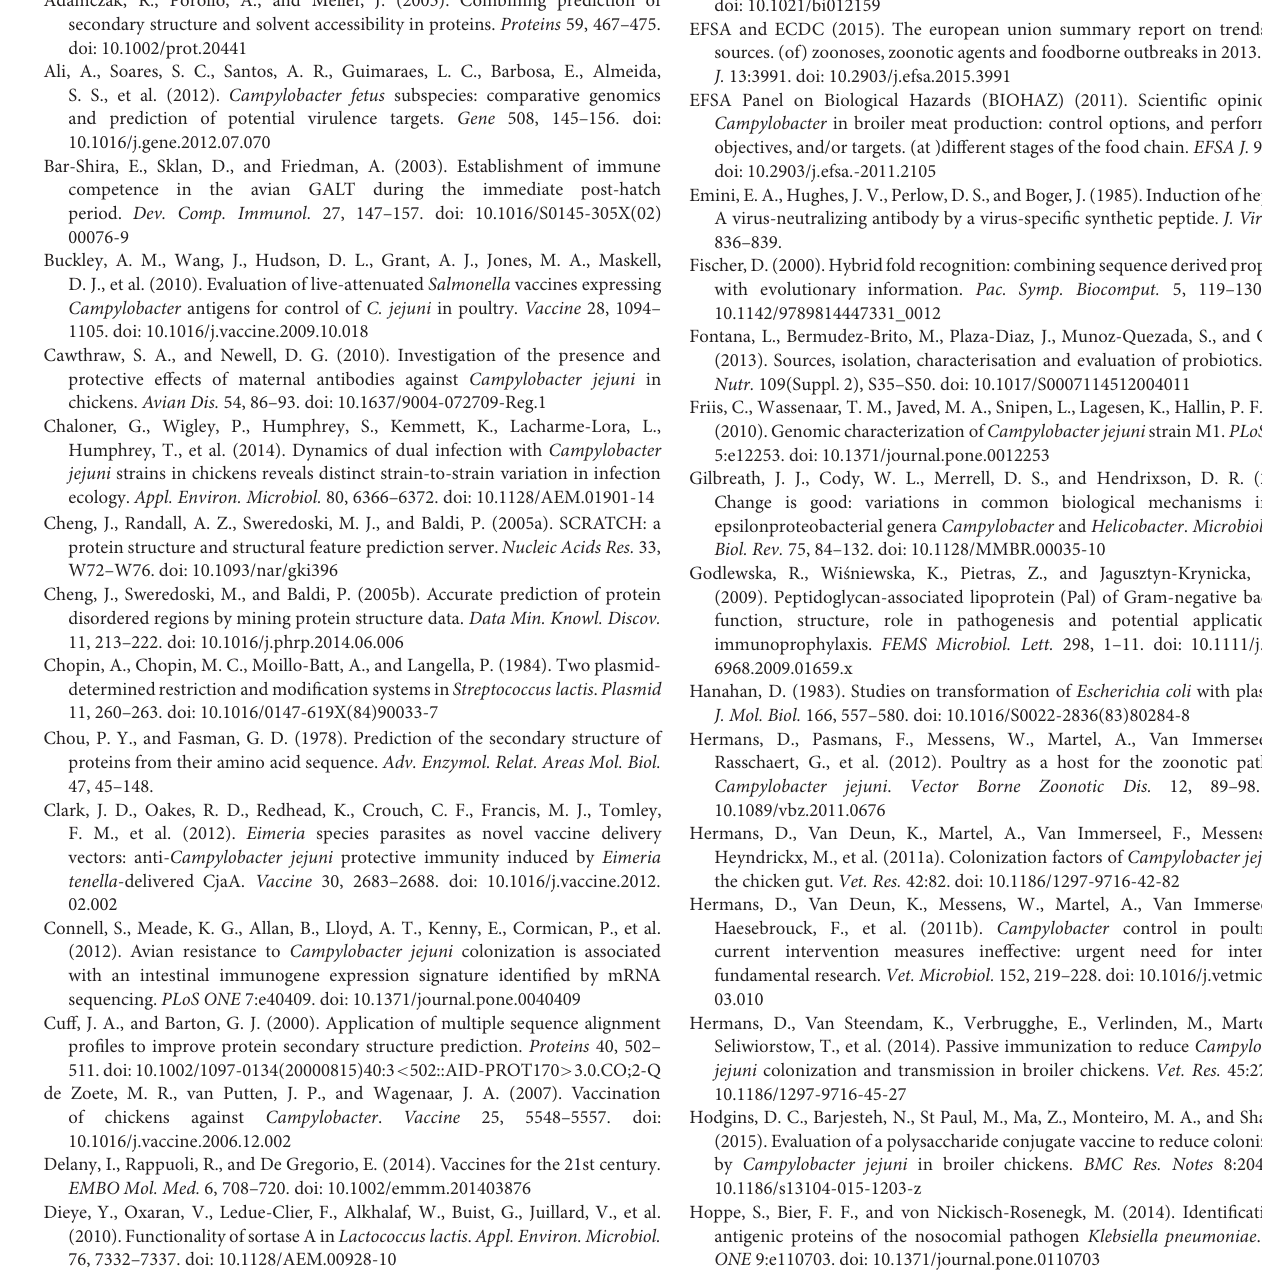
all possible combinations. Amino acids between which epitopes of CjaD protein were inserted are indicated in red. FIGURE S3 | The scheme of pUWM1392 and pUWM1395 construction. FIGURE S4 | The production of CjaA and rCjaAD by L. lactis. Protein extracts were separated by 12% SDS-PAGE under reducing conditions and probed with anti-rCjaAD antibodies. Lanes: M - protein molecular-weight marker, 1 – L. lactis /pUWM1392, 2 – L. lactis /pUWM1395; 3 – L. lactis